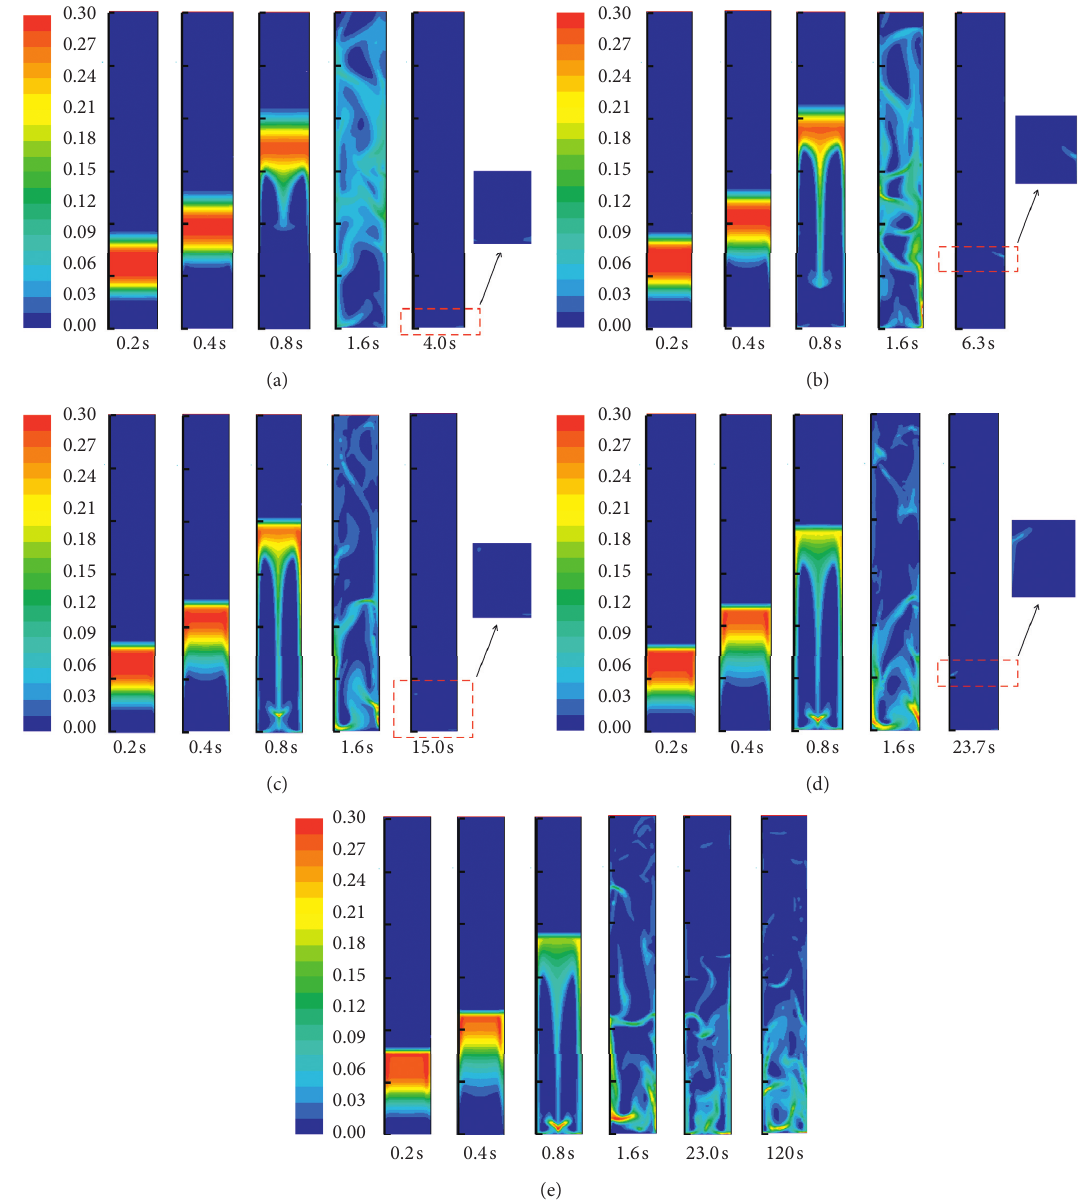
Figure 6: Volume fraction of dust: u � 0.70 m/s and ρ � 1100kg/m 3 . (a) d � 0.05 mm. (b) d � 0.10mm. (c) d � 0.15mm. (d) d � 0.18mm. (e) d �